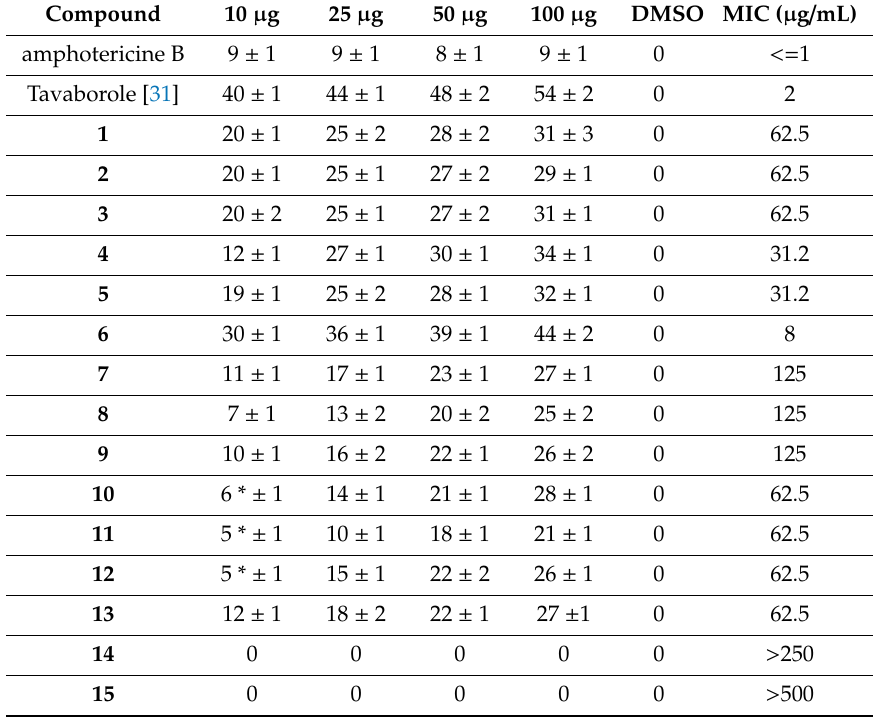
Table 1. The average diameter of the zone of totally inhibited growth of Candida albicans at various amounts (mm) and Minimal Inhibitory Concentration ( µ g /